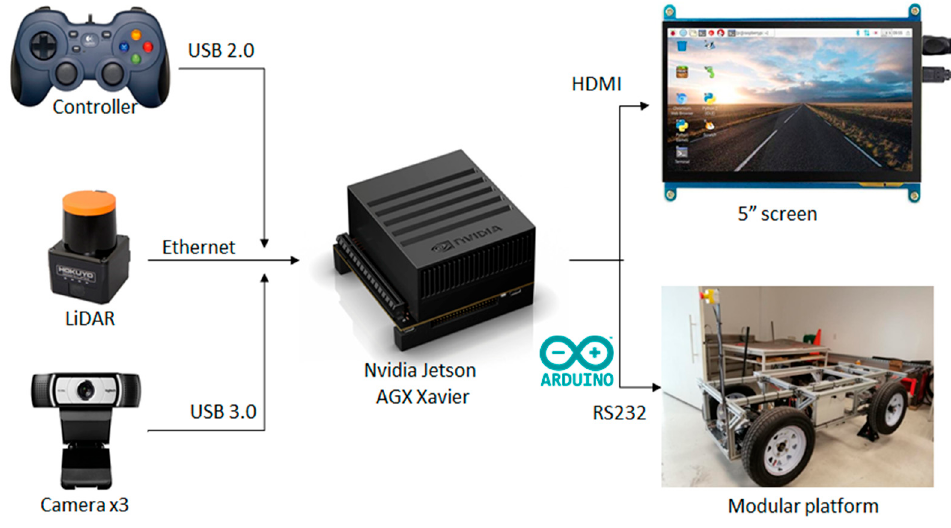
Figure 4. Instrument connection diagram.